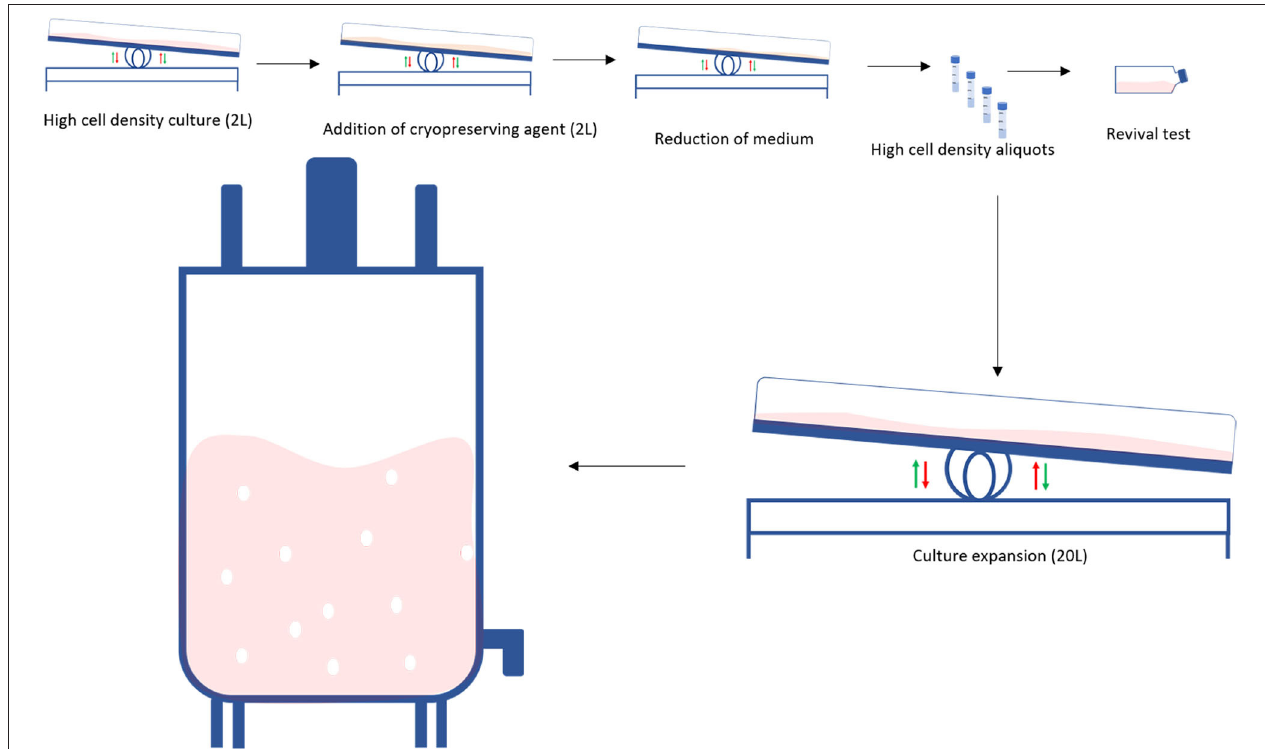
FIGURE 3 | Obtaining a high-density cell bank: High density cell banks are used to reduce the required steps in the traditional scale-up process to generate larger numbers of cells. Initially, cells are grown at a high cell density in a perfusion bioreactor, a cryopreservation is added to the culture and the volume is reduced. Cells are then banked as high-density aliquots in cryovials. When required, a test vial is revived. If the revival is successful, the high-density aliquots are seeded into a perfusion bioreactor which is subsequently seeded into a larger